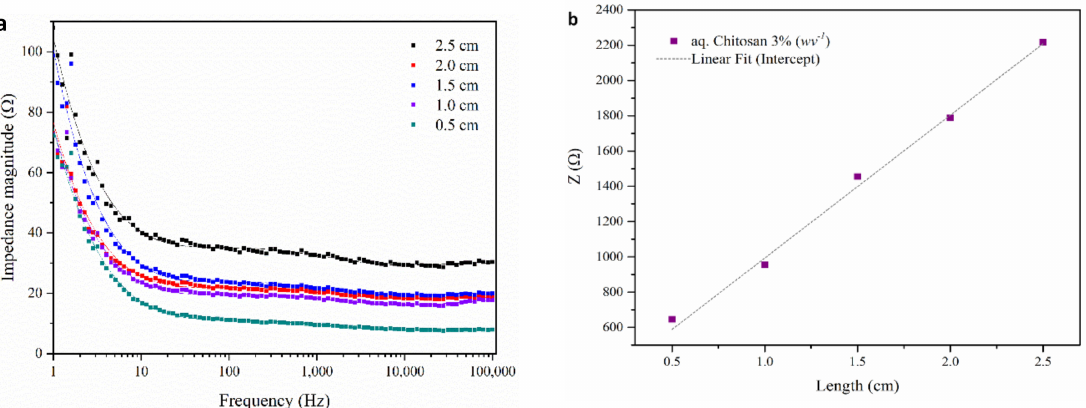
Figure 4. Electrical impedance analysis of chitosan hydrogel 3% w v − 1 with 0.5% NaCl; ( a ) Bode plot and ( b ) impedance as a function of sample length in wet-state fibers.